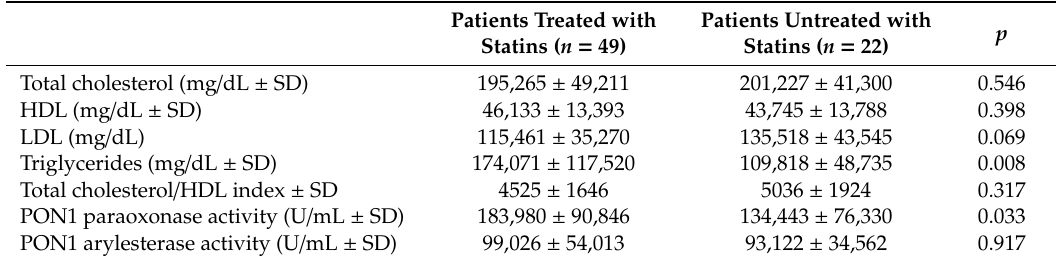
Table 4. Comparison of lipid profile and PON1 activity towards paraoxon and phenyl acetate in subgroups of patients treated or not treated with statins (Mann–Whitney U test).